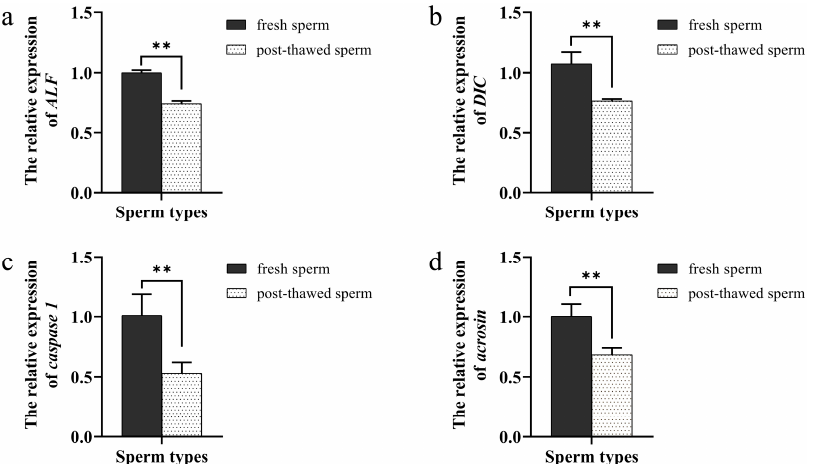
Figure 7. The expression of sperm-related gene in P. trituberculatus fresh and frozen sperms. ( a ) The expression of Aalpha/beta-like factor ( ALF ). ( b ) The expression of DIC . ( c ) The expression of caspase 1 . ( d )